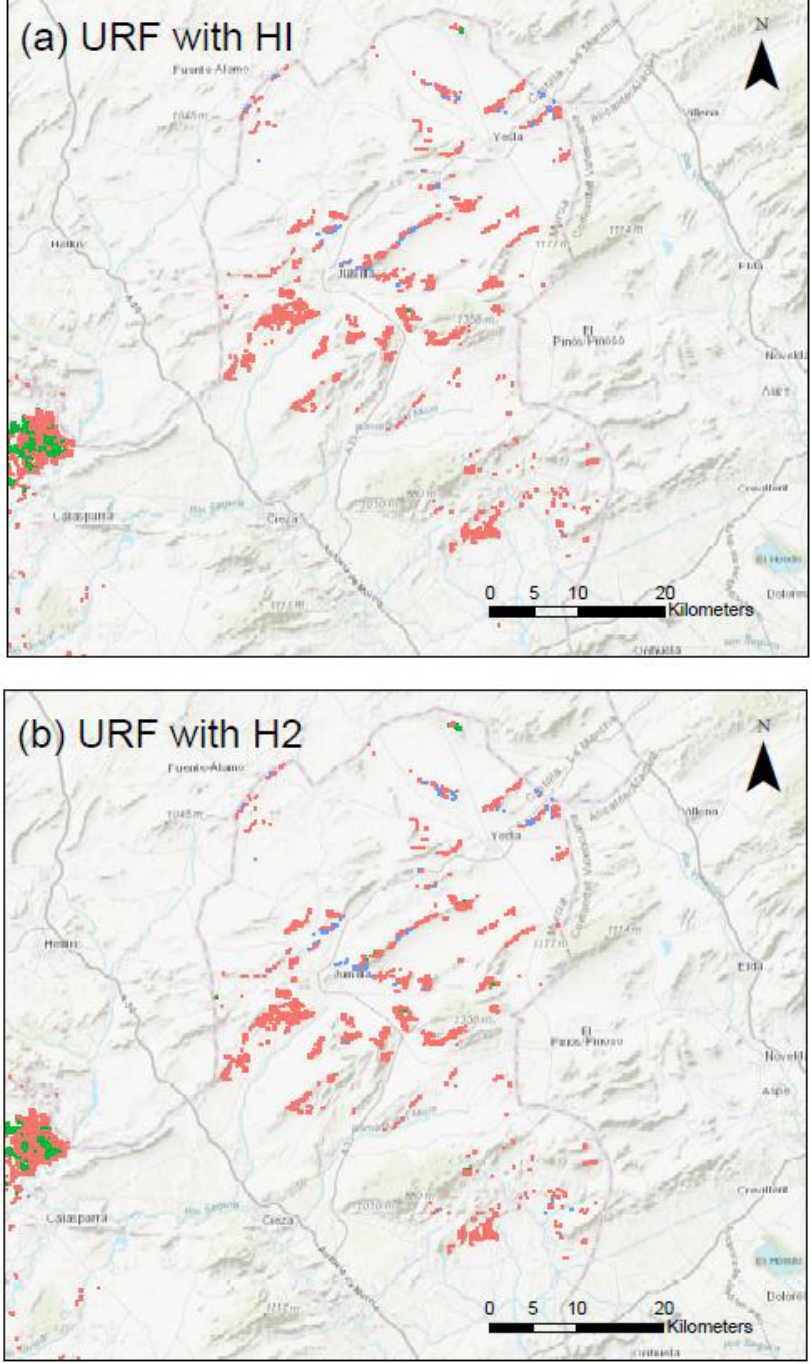
Figure A4. Comparison of the clustering results for URF using HI ( a ) and H2 ( b ) in the agricultural region of Murcia-NE. Cluster 1 is pink, cluster 2 is green, and cluster 3 is blue.